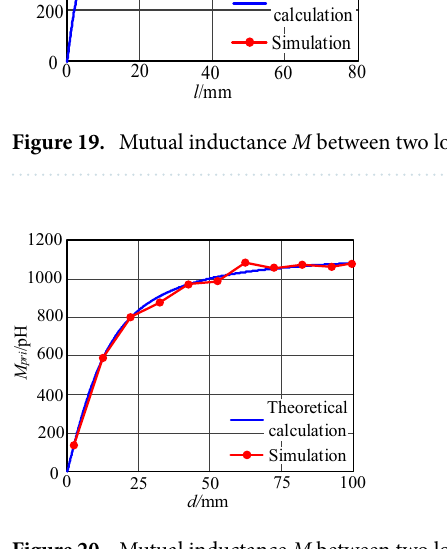
Figure 20. Mutual inductance M between two loops varies with d